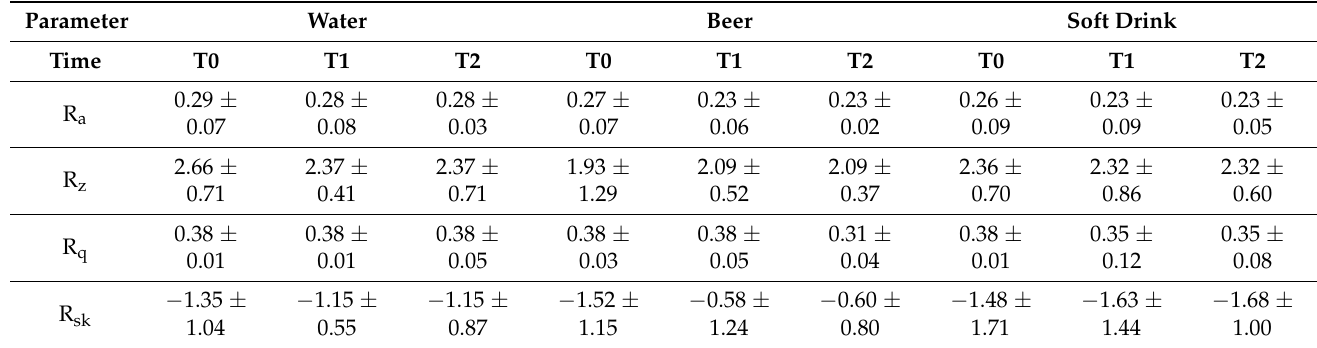
Table 6. Results regarding roughness of composite resin